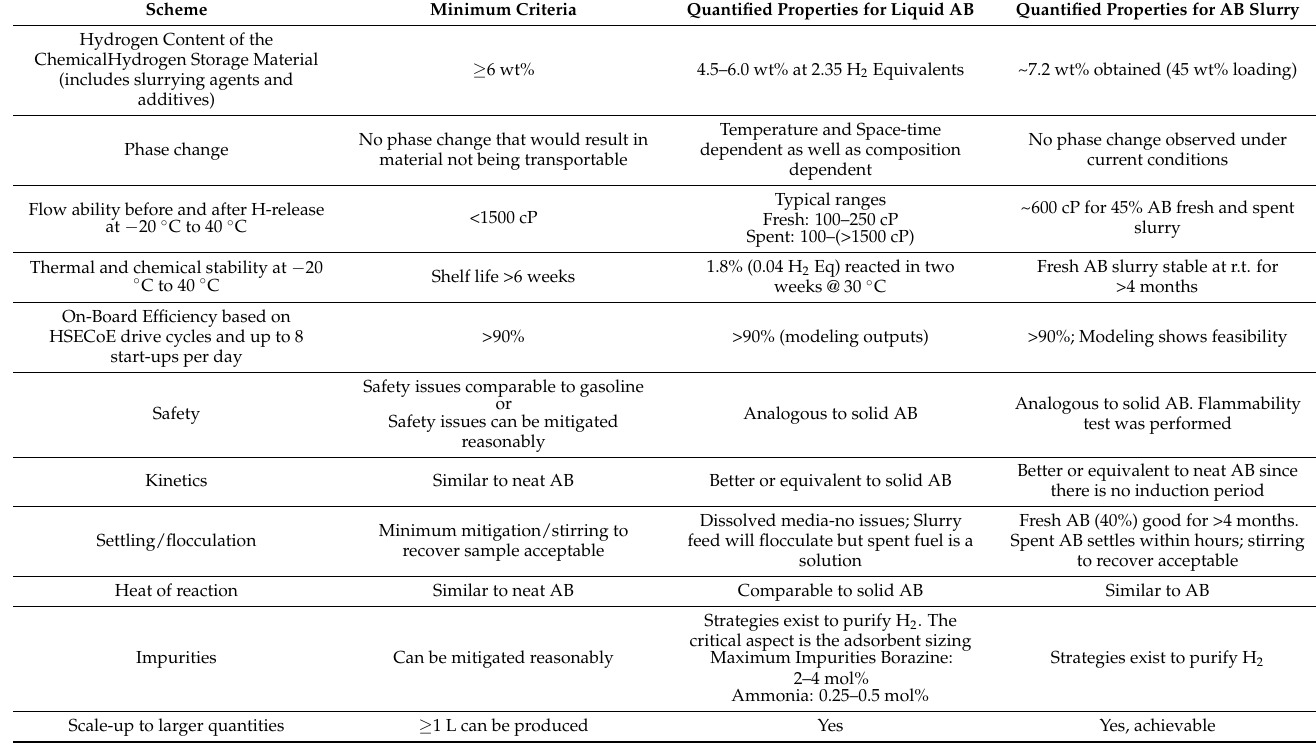
Table 4. Evaluation of materials operating requirements for fluid-phase ammonia borane